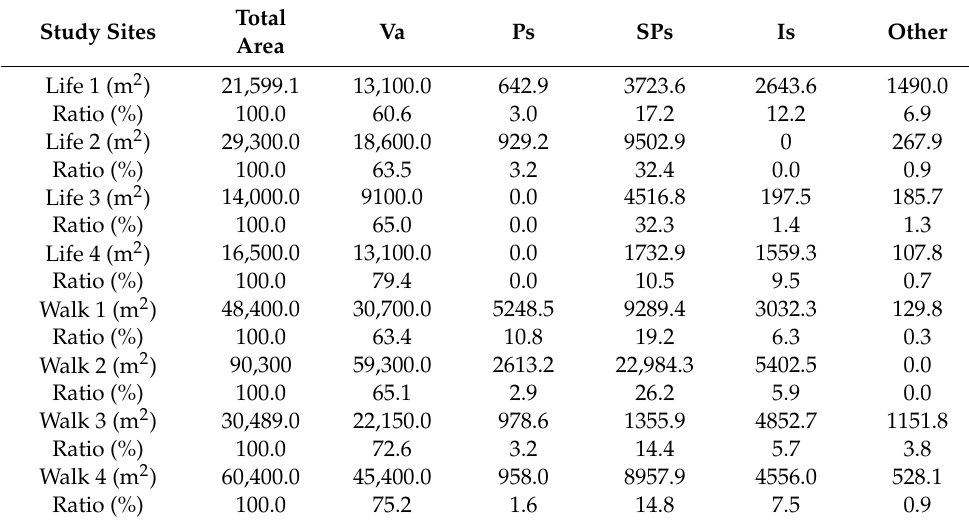
Table 3. Analysis of the status of the land cover of the study